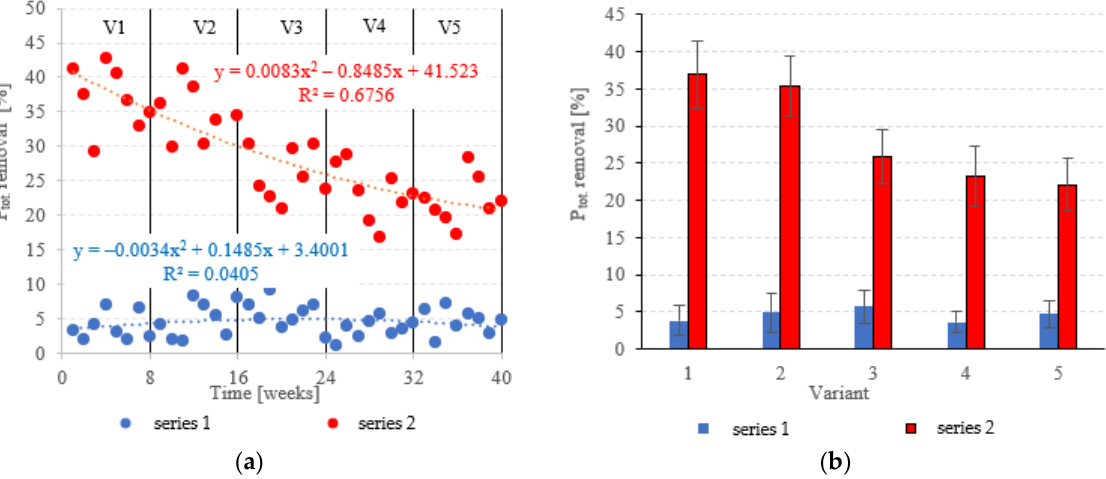
Figure 11. P tot. removal (( a ) changes throughout the experiment; ( b ) average across experimental variants).